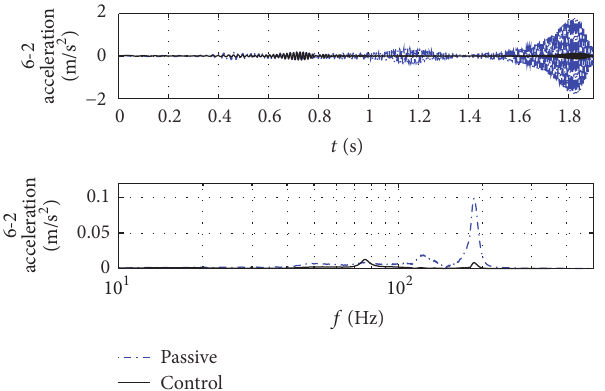
Figure 17: Comparison time-frequency domain curves of accelera- tion response of position 6-2 on the isolation system before and after being controlled under double linear swept sine